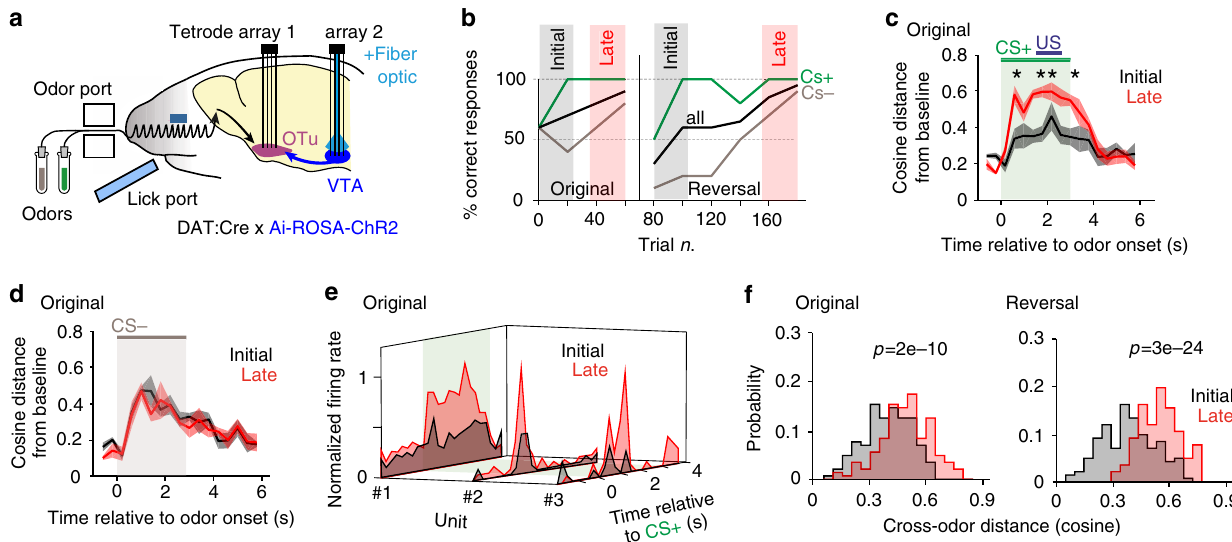
Fig. 3 Value assignment to sensory stimuli in the ventral striatum during reversal learning. a To assess how stimulus-triggered neuronal responses are modi fi ed during reversal learning, we performed recordings in head- fi xed mice of VTA and OTu. ChR2-expression in DAN allowed for optogenetic tagging. b Exemplary performance of a mouse learning the go-/no-go task (original phase). Once criterion was reached, the odor-reward contingency was reversed (reversal phase) within the session. To reveal changes after learning, each phase was divided into an ‘ initial ’ phase (comprising the fi rst 12 CS + and 12 CS − trials) and a ‘ late ’ phase (last 12 CS + and 12 CS − trials). c , d The cosine distance of the population vector from baseline changed for CS + (but not CS − ) from the initial to the late trials (two-sided t -test, asterisks mark signi fi cance at α = 0.05 with Benjamini – Hochberg correction). Displayed mean±S.E., n = 4 trial- averages of three trials, respectively, for both ‘ initial ’ and ‘ late ’ . e Examples of normalized PSTH of responses to CS + in the initial and late trials in 3 SPN. f Distribution of cosine distances between CS + and CS − representation in initial and late trials, respectively. During learning, CS + and CS − representations diverged both in the original and reversal phase (two-sided t -test). Source data are provided as a Source data fi le. See also Supplementary Figs.